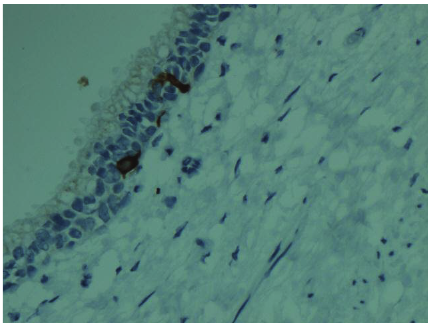
Figure 3: Immunohistochemical staining (columnar lined cells expressing both chromogranin and